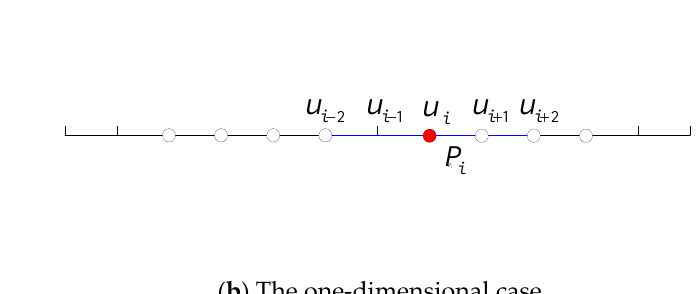
( b ) The one-dimensional case Figure 6. The knot vector for a control point of cubic